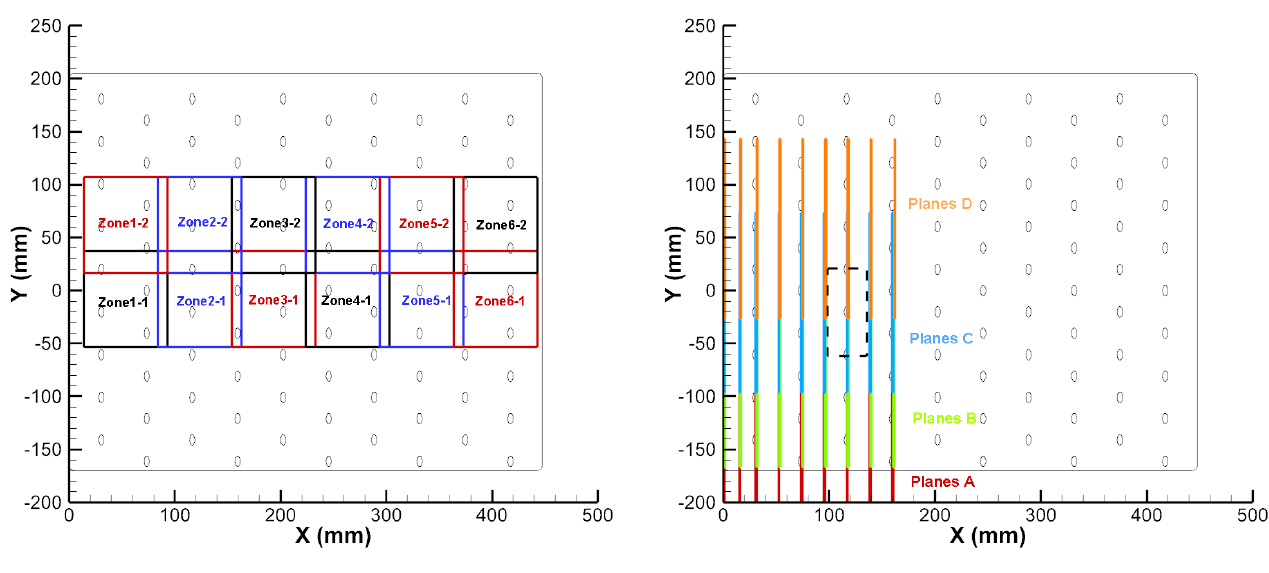
Figure 3. Location of SPIV measurement planes—Note that X-position 0 refers to the upstream limit of the multi perfo- rated